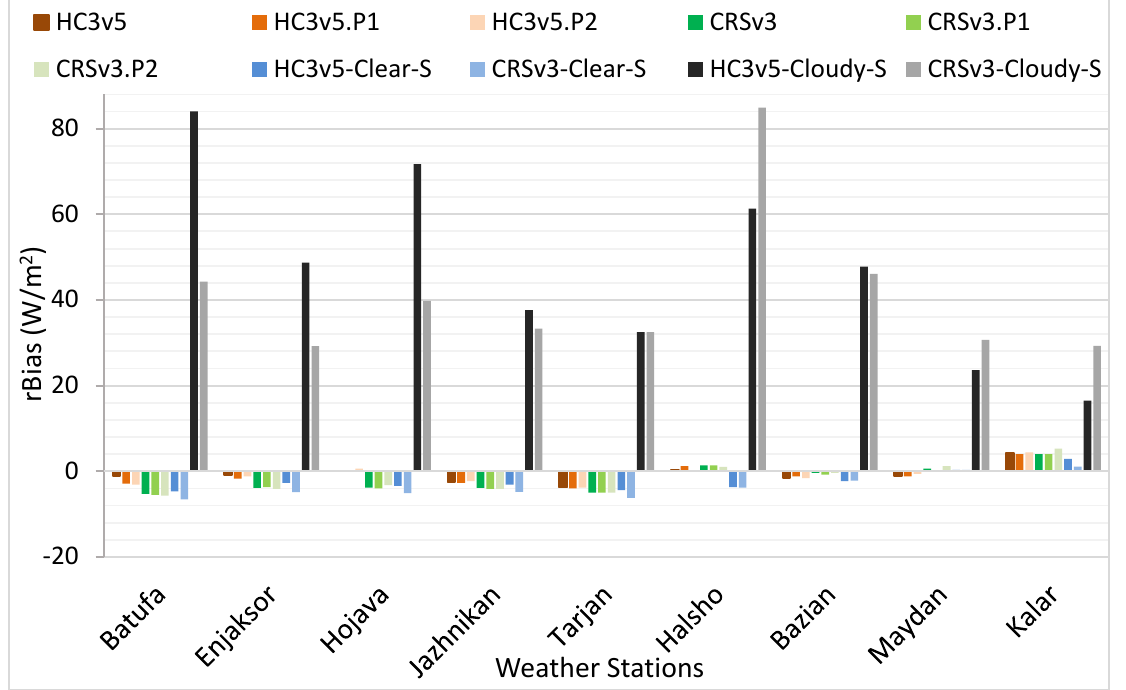
Figure 6. Monthly mean and standard deviation of hourly GHI data in each month aggregated over data availability for each station with CRSv5. The difference between dots reveals errors in a month and vice versa. If the dot of the SDD in a month is above the dot of the ground data, it denotes overestimation; otherwise, it denotes underestimation.